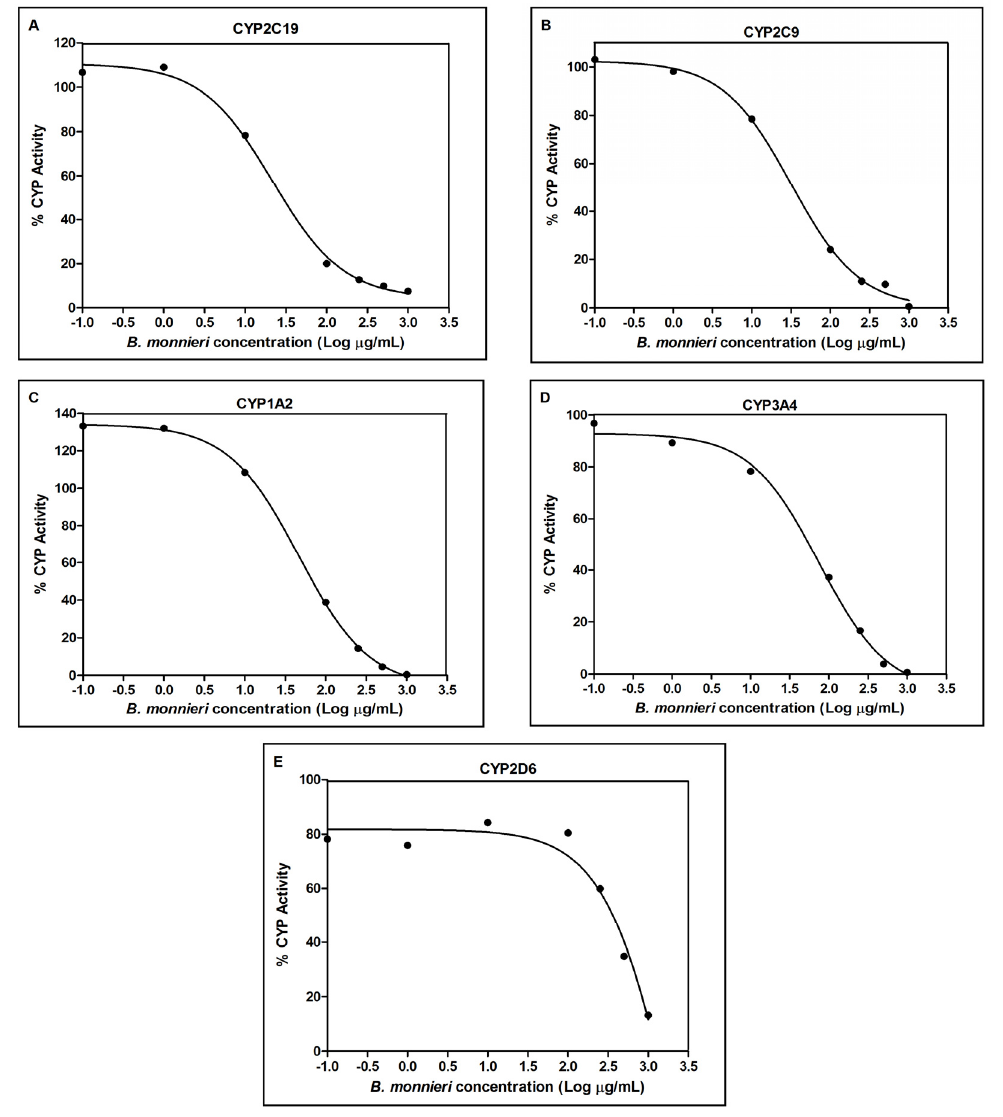
Figure 2. B. monnieri extract showed strongest inhibitory effects towards CYP2C19 ( A , IC = 23.67 µg/mL) followed by CYP2C9 ( B , 36.49 µg/mL), CYP1A2 ( C , 52.20 µg/mL), 50 CYP3A4 ( D , 83.95 µg/mL) and CYP2D6 ( E , IC represents the average of triplicate